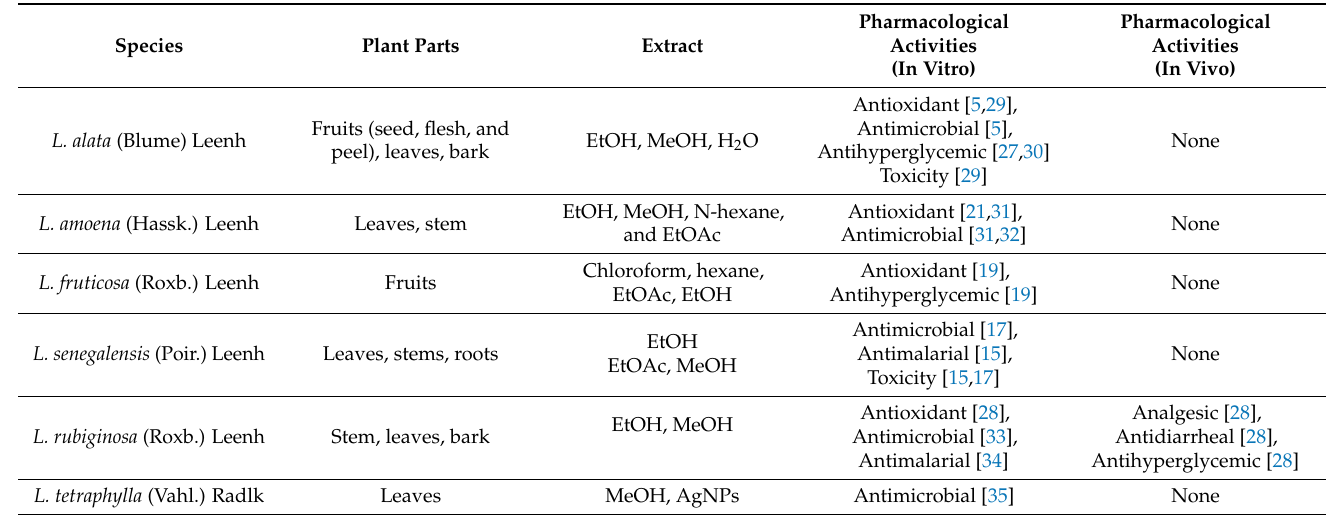
Table 3. Overall pharmacological activities of Lepisanthes species